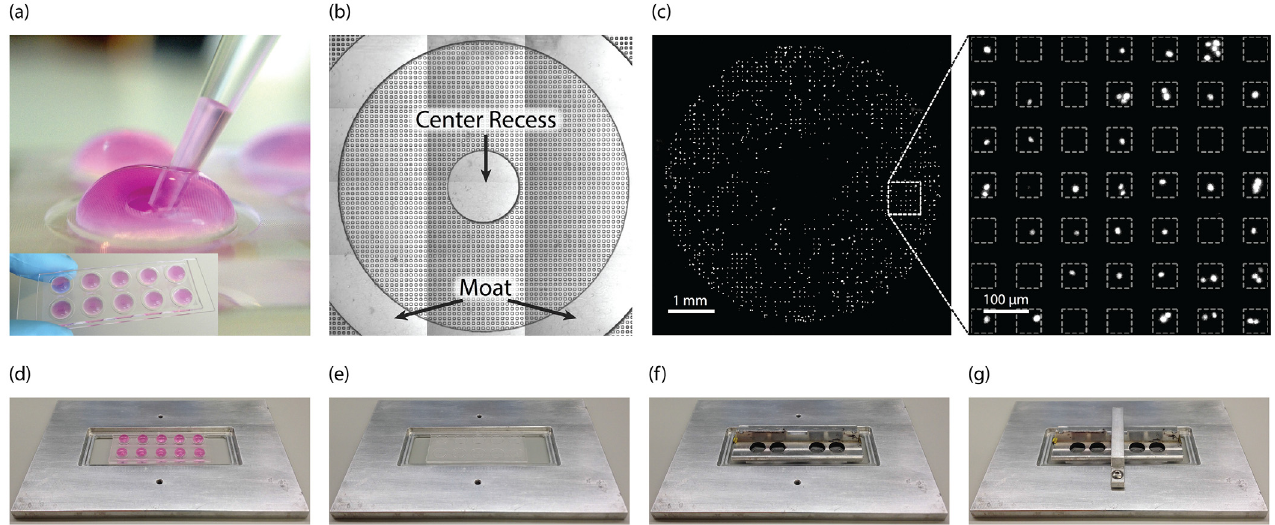
Fig 4. New microwell array (MA) device design and assembly for single-cell studies. (a) Regions of microwells are isolated from one another using grooves or ‘ moats ’ allowing multiple conditions to be tested on a single device using surface tension to maintain the droplets. Each isolated region is referred to as a bull ’ s-eye given its appearance. (inset, d, f) Twelve bull ’ s-eyes in a 2×6 array fit on a standard glass slide. The device is trimmed to include 2×5 and only the outer 8 can be imaged through the clamp device. (b-c) The array of bull ’ s-eyes containing * 2500 microwells each are placed on a microscope slide. Cells in suspension within each droplet settle into microwells randomly for easy loading and are visualized using nuclear staining. Cells are identified and counted using image analysis. Only wells containing a single cell are considered. The image in (b) is a stitched phase contrast image, (c) is the same image with fluorescent nuclei visible, and the magnified image indicates the size and shape of individual microwells. (d-g) Device assembly. (d) The slide of bull ’ s- eyes is placed in the base of the microscope insert. (e) The droplets are removed and a glass slide is placed over the bull ’ s-eyes. (f) The pressure distributor of the microscope stage insert is placed over the glass slide lid. (g) The top plate is fastened with a bracket using two hex screws. The device is sealed and ready for time-lapse imaging.